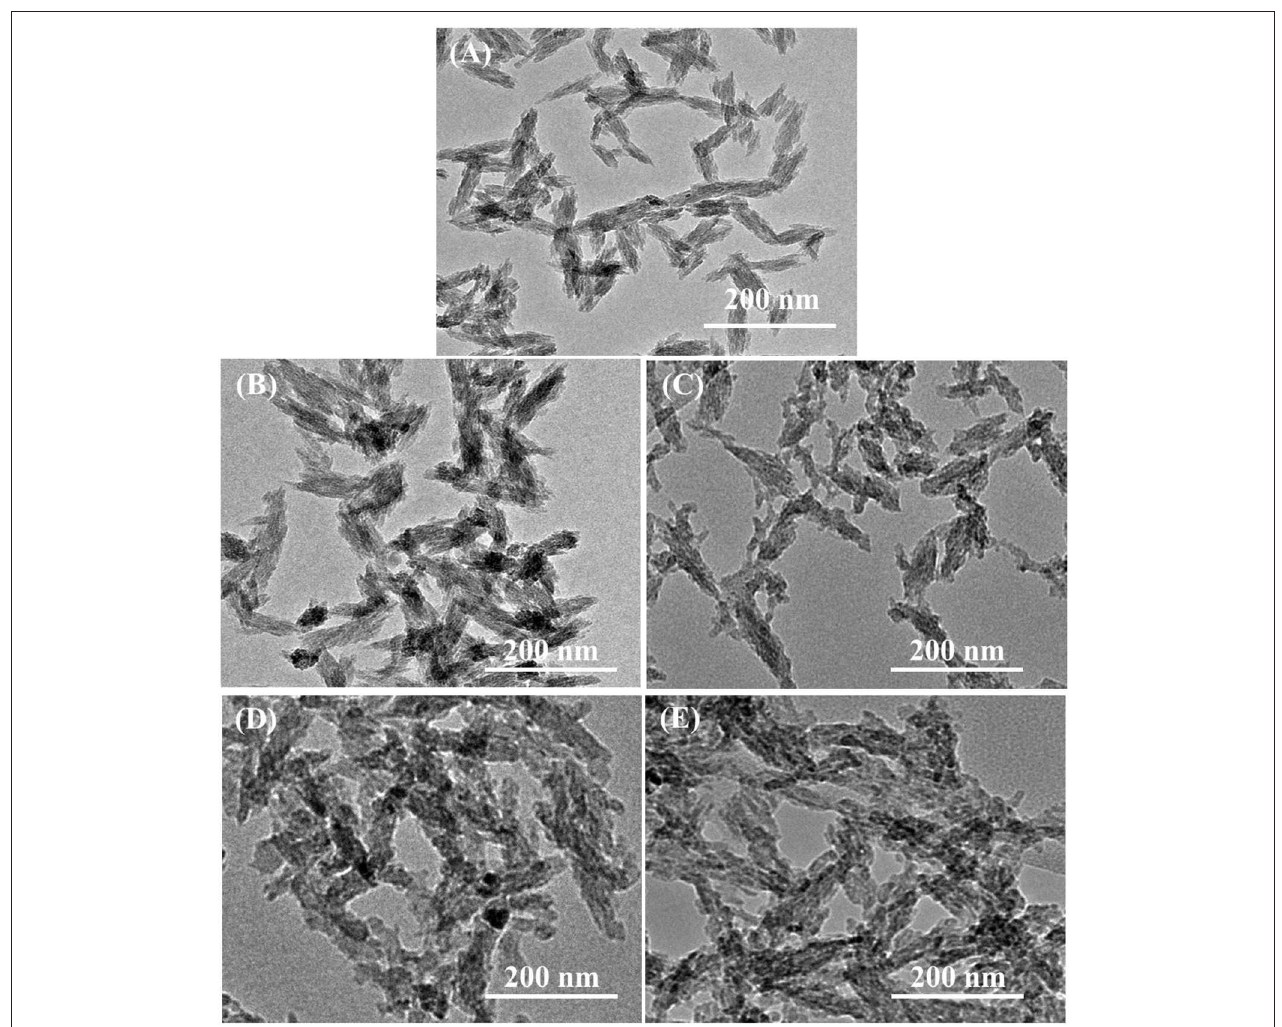
FIGURE 3 | Transmission electron micrographs of (A) pristine HAp nanoparticles and (B) Se-HAp, (C) CC/Se-HAp1, (D) CC/Se-HAp2, and (E) CC/Se-HAp3